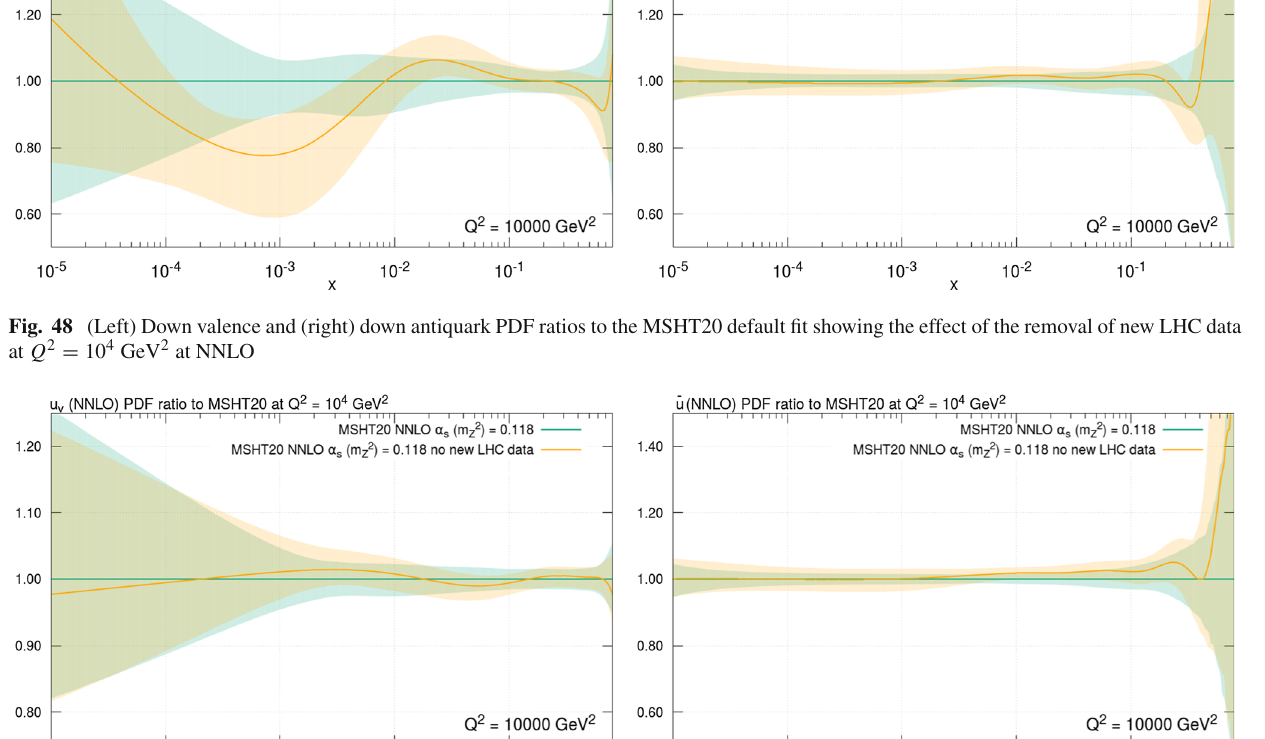
a broader peak exists even without the new LHC data. This is due in part just to the parameterisation